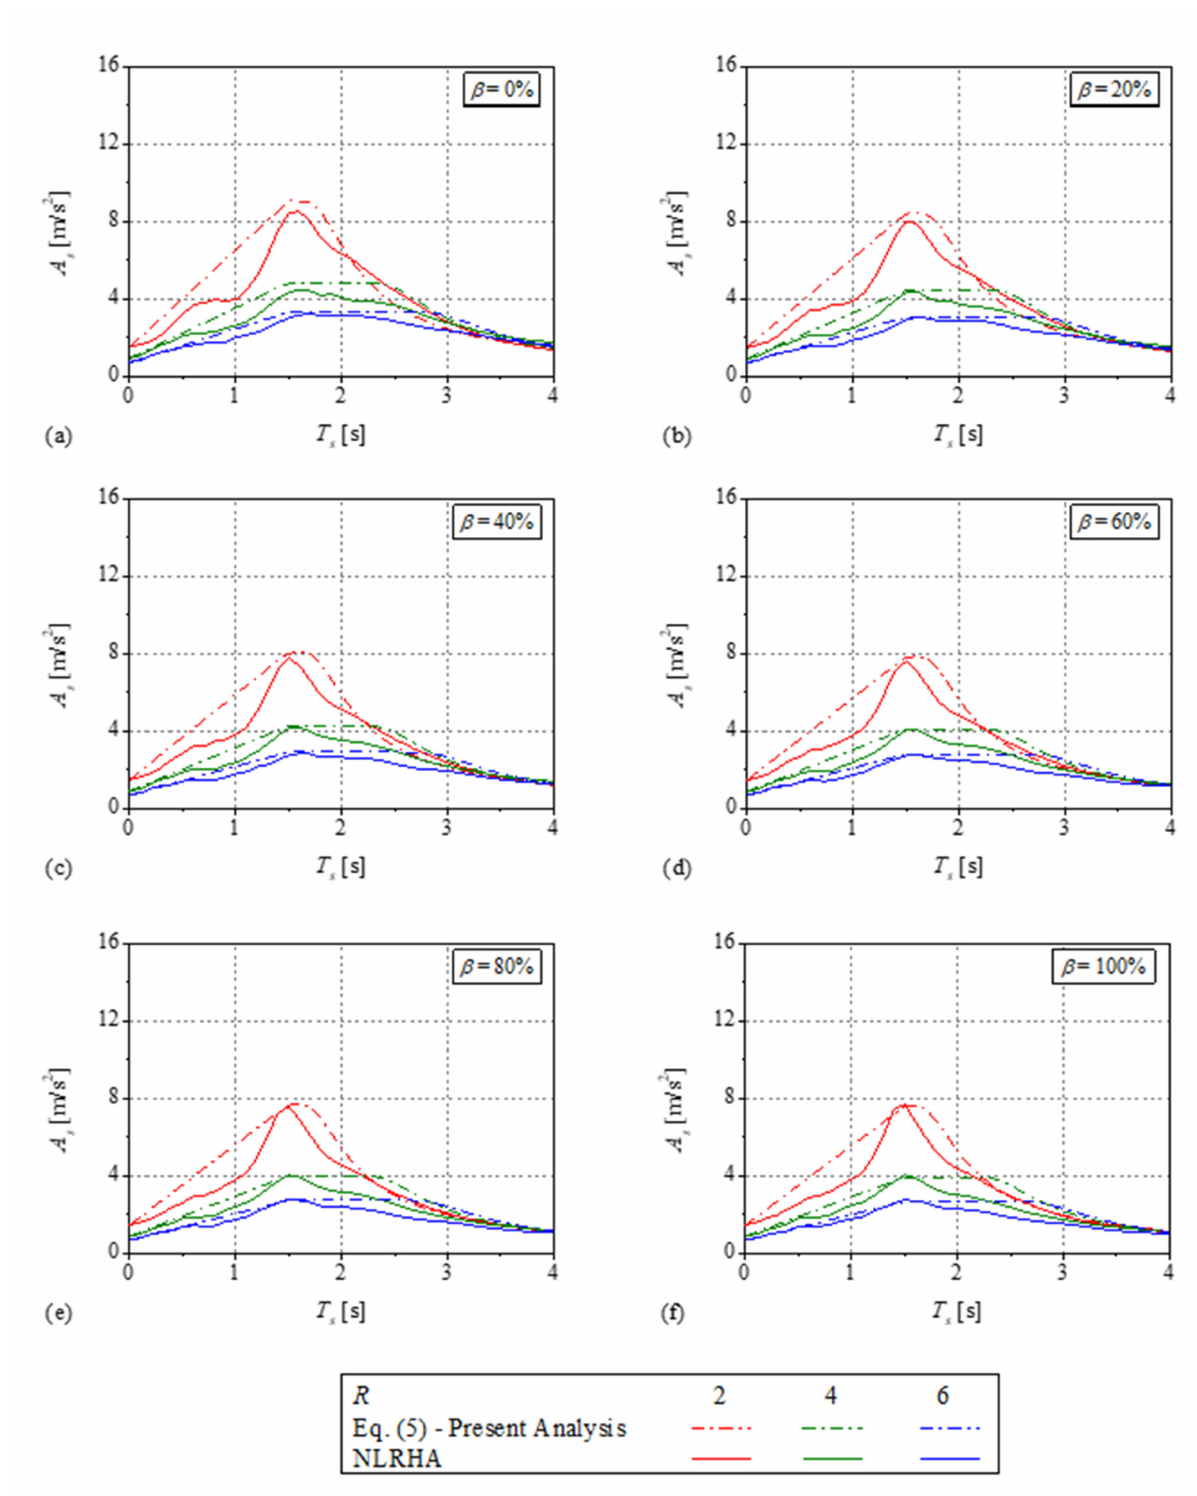
Figure 9. Comparison of the mean floor response spectra from Equation (5) and NLRHA for a primary structure with initial vibration period T p = 1.5 s, post-yield stiffness ratio α = 5%; viscous damping ratio ξ p = 5%; and a secondary structure with viscous damping ratio ξ s = 5%: ( a ) β = 0%; ( b ) β = 20%; ( c ) β = 40%; ( d ) β = 60%; ( e ) β = 80%; and ( f ) β =